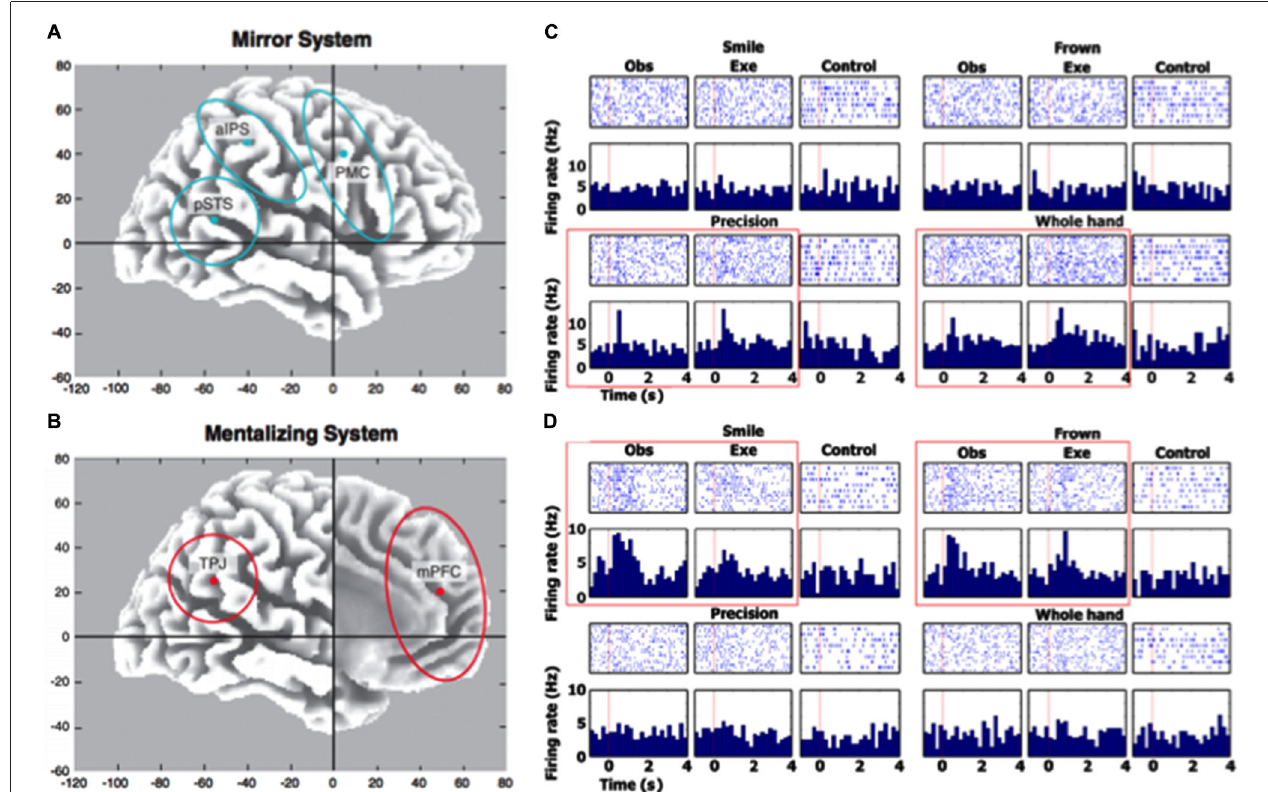
mentalizing system. Panels C and D (figure and caption are reprinted from Mukamel et al. (2010) with permission from Elsevier) show neural responses of two cells during all experimental conditions and tasks, which depicts an action observation/execution matching multiunit in left SMA for the two grips (precision and whole-hand; panel C ) and an action observation/execution matching single unit in right entorhinal cortex for two facial gestures (smile and frown; panel D ). Rasters (top) are aligned to stimulus onset (red vertical line at time = 0). Bin size for peristimulus time histogram (bottom) is 200 ms. Red box highlights responses passing statistical